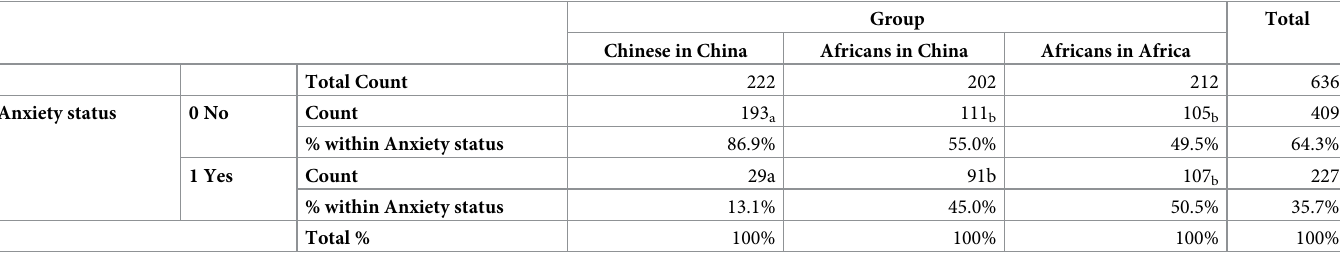
Table 3. Prevalence of